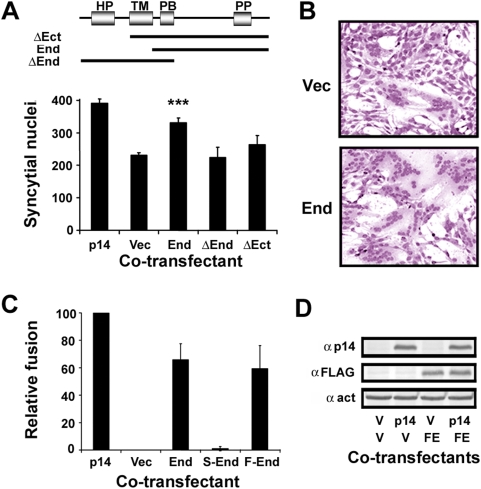
The p14 endodomain peptide enhances p14-induced syncytiogenesis.(A) Top panel: Arrangement of structural motifs in the p14 FAST protein, and the regions present in the N- (ΔEct) and C- (ΔEnd) terminally truncated p14 constructs and the endodomain construct (End) are depicted. HP, hydrophobic patch; TM, transmembrane domain; PB, polybasic region; PP, polyproline region. Bottom panel: QM5 fibroblasts transfected with a plasmid expressing p14 were co-transfected with plasmids expressing full-length p14 (p14), empty vector (Vec), the p14 endodomain (End), or p14 with a deleted endodomain (ΔEnd) or deleted ectodomain (ΔEct), and triplicate samples were quantified for the extent of cell–cell fusion at 8 h post-transfection. Values are the average number of syncytial nuclei per field±S.E. (n = 4). Only the endodomain construct, indicated with the asterisks, resulted in a statistically significant increase in syncytium formation (p<0.001) relative to the cells co-transfected with p14 plus empty vector. (B) The extent of syncytium formation present in cells co-transfected with p14 plus empty vector (Vec) or p14 plus the p14 endodomain (End) was visualized by bright field microscopy of Giemsa-stained monolayers at 8 h post-transfection. (C) Cells transfected with the p14 expression plasmid were co-transfected with plasmids expressing authentic p14 (p14), empty vector (Vec), the p14 endodomain (End), or a scrambled (S-End) or N-terminally FLAG-tagged (F-End) version of the p14 endodomain. The extent of cell–cell fusion was quantified as described in (A), and results are presented as the relative level of syncytium formation±S.E. (n = 4), setting the cells co-transfected with authentic p14 as 100% fusion enhancement and those co-transfected with empty vector as 0% fusion enhancement. (D) Cell lysates from cells co-transfected with the indicated expression plasmids (p14, authentic p14; V, empty vector; FE, FLAG-tagged p14 endodomain) at 12 h post-transfection were processed for Western blotting using antibodies against p14, the FLAG epitope, or β-actin (indicated on the left).